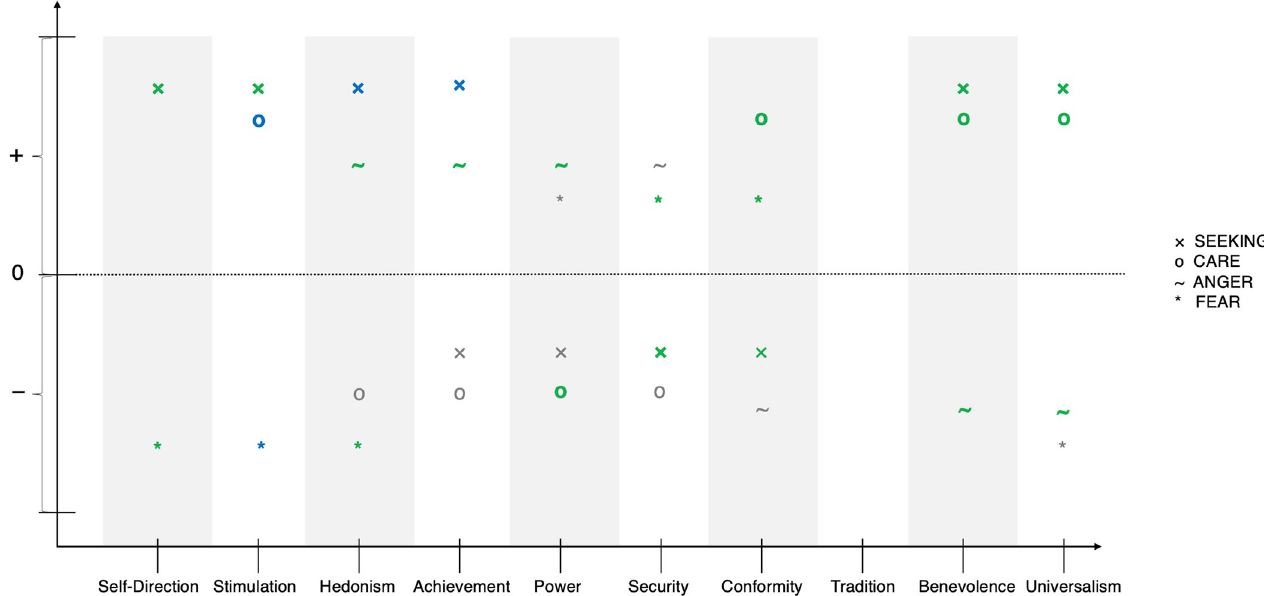
Fig 2. Significant correlations related to the initially reported hypotheses on value type relations. Green indicates that a hypothesis was supported by the data, grey indicates that a hypothesis was not supported by the data, blue indicates that relations were found that were not hypothesized (only related to SEEKING, CARE, ANGER,